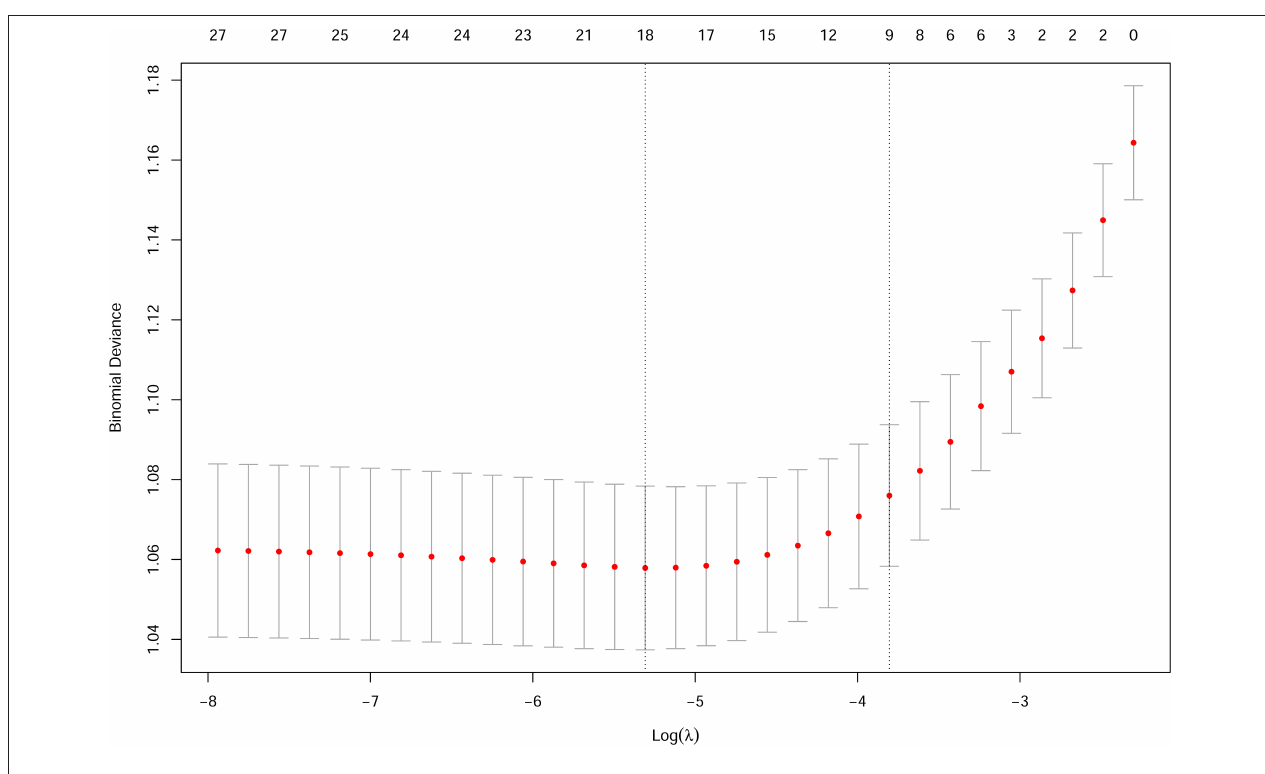
FIGURE 2 | Cross validation plot for the penalty term for childhood wheeze.